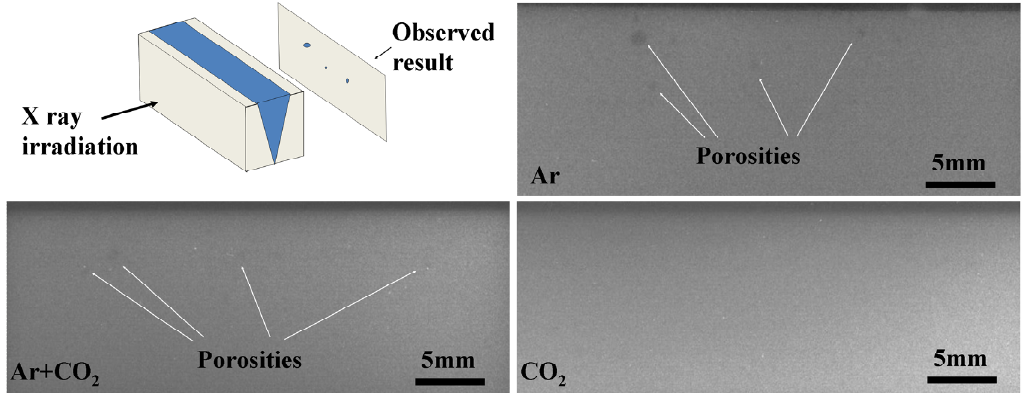
Figure 7. Influence of shielding gases on weld porosity.